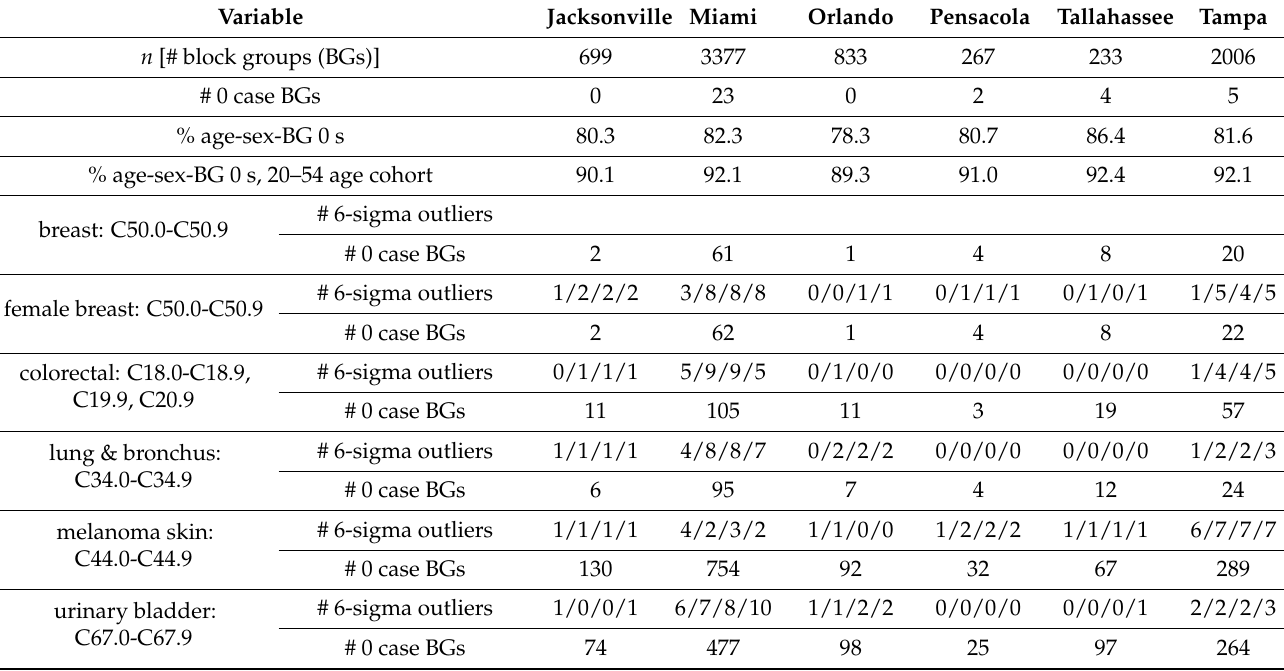
Table 3. Non-normal frequency distribution tail characteristics: zeroes and extreme large-value outliers.